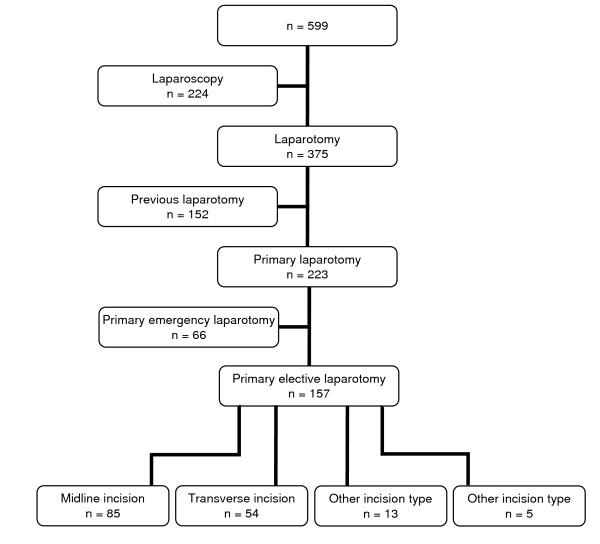
Flow-chart on the number of available data entry forms and patients included in the final analysis.